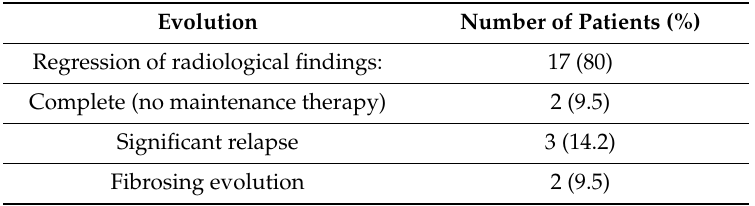
Table 11. Di ff erent kinds of evolution of the 21 patients who received steroid